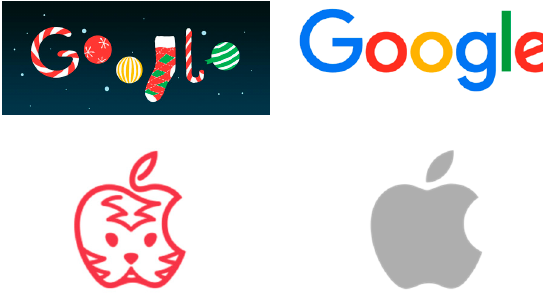
Figure 1. Holiday-themed logos vs. regular logos of Google and Apple (China).